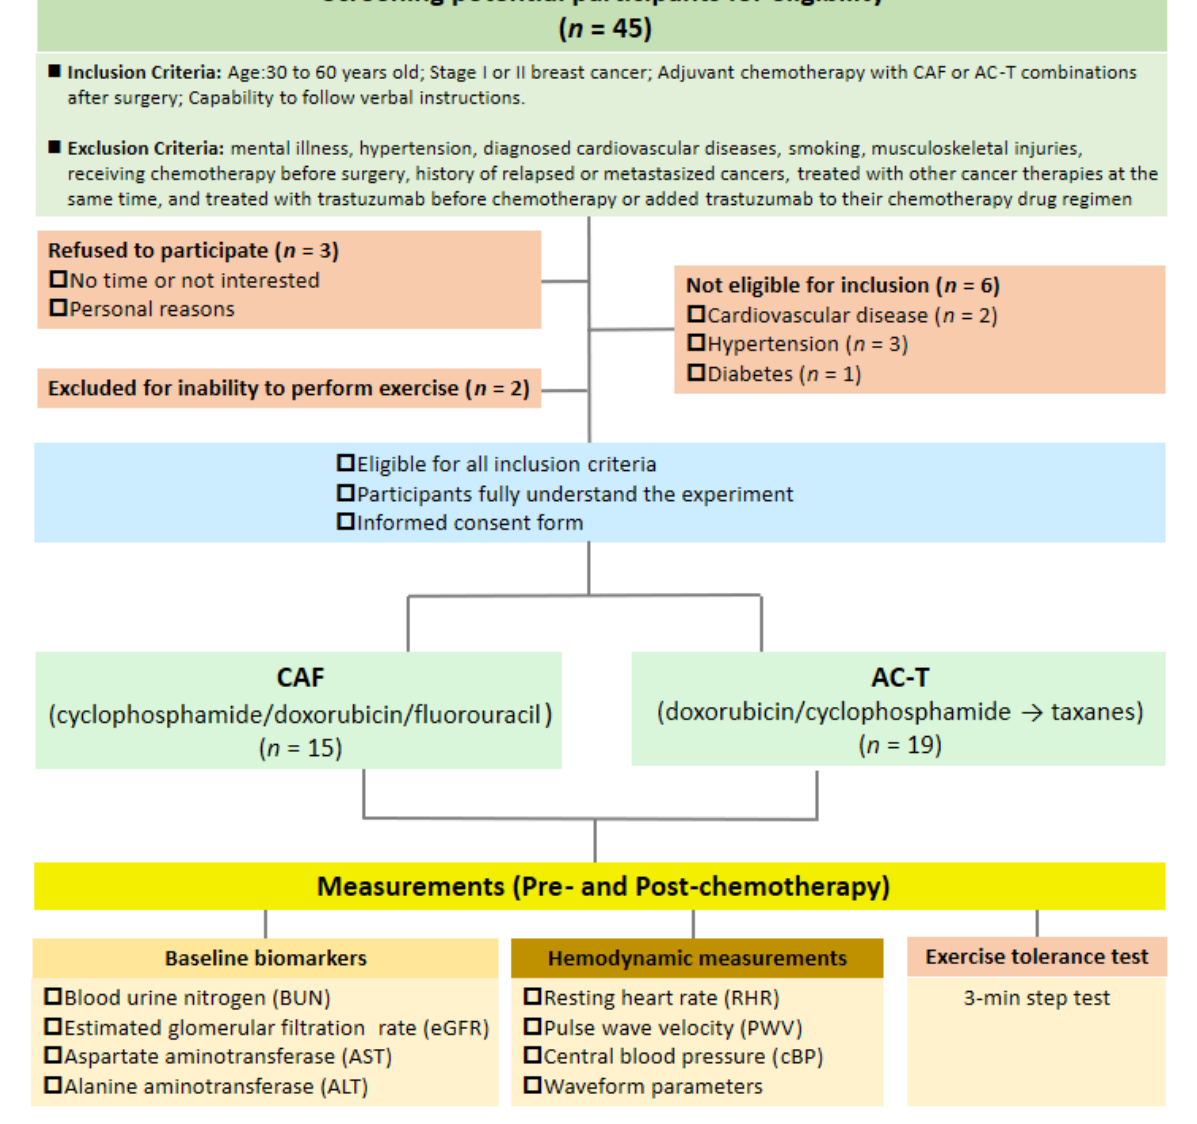
Figure 1. Flow chart of the study participants’ screening and recruitment.